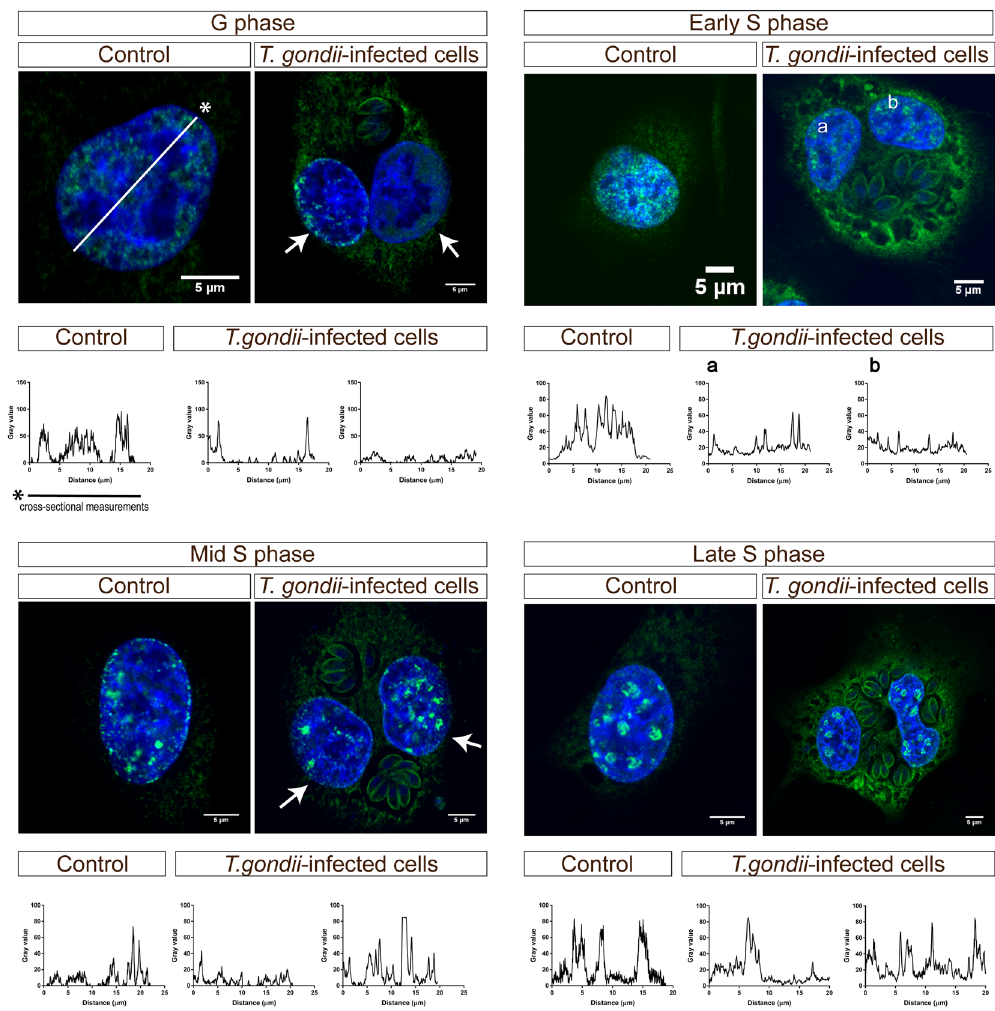
Figure 6. Expression of PCNA in binucleate T. gondii -infected BUVEC. T. gondii -infected BUVEC and control cells were stained for DNA via DAPI (blue) and for Proliferating cell nuclear antigen (PCNA, green) and analyzed via confocal microscopy. The nuclei of binucleate cells are indicated by white arrows. To analyze the nuclear PCNA distribution, we measured the intensity of PCNA-related signals by drawing a longitudinal line over the nuclei and plotting these data as a graph showing intensity value vs distance (in µ m). ( a ) = left and ( b ) = right nucleus of a binucleate cell. Scale bar represents 5 µ